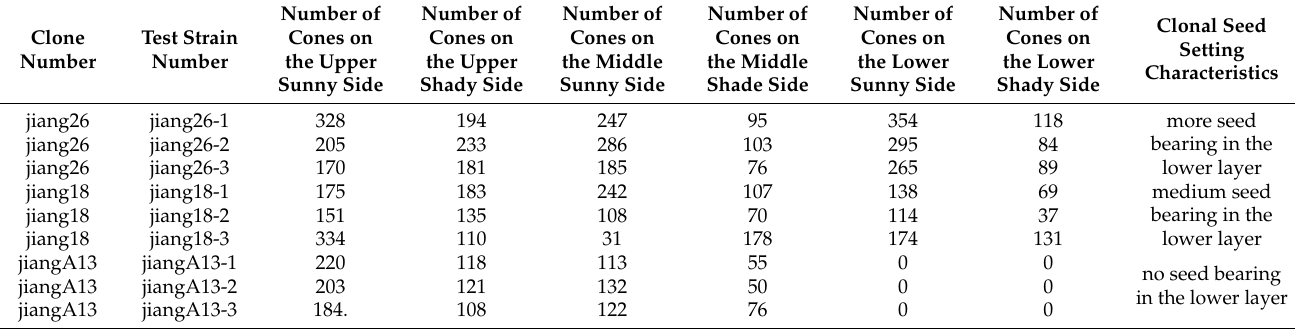
Table 1. Basic information about the three Chinese fir clones assessed in the